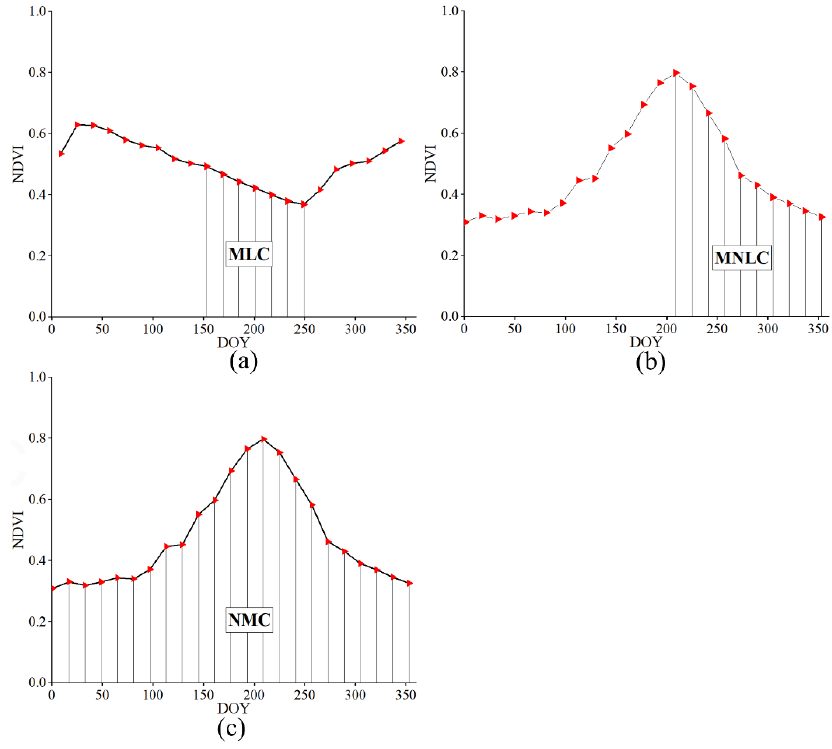
Figure 3. Temporal variation in the three sets of NDVI (Pointed out by vertical line). ( a ) MLC, ( b ) MNLC, and ( c ) NMC.